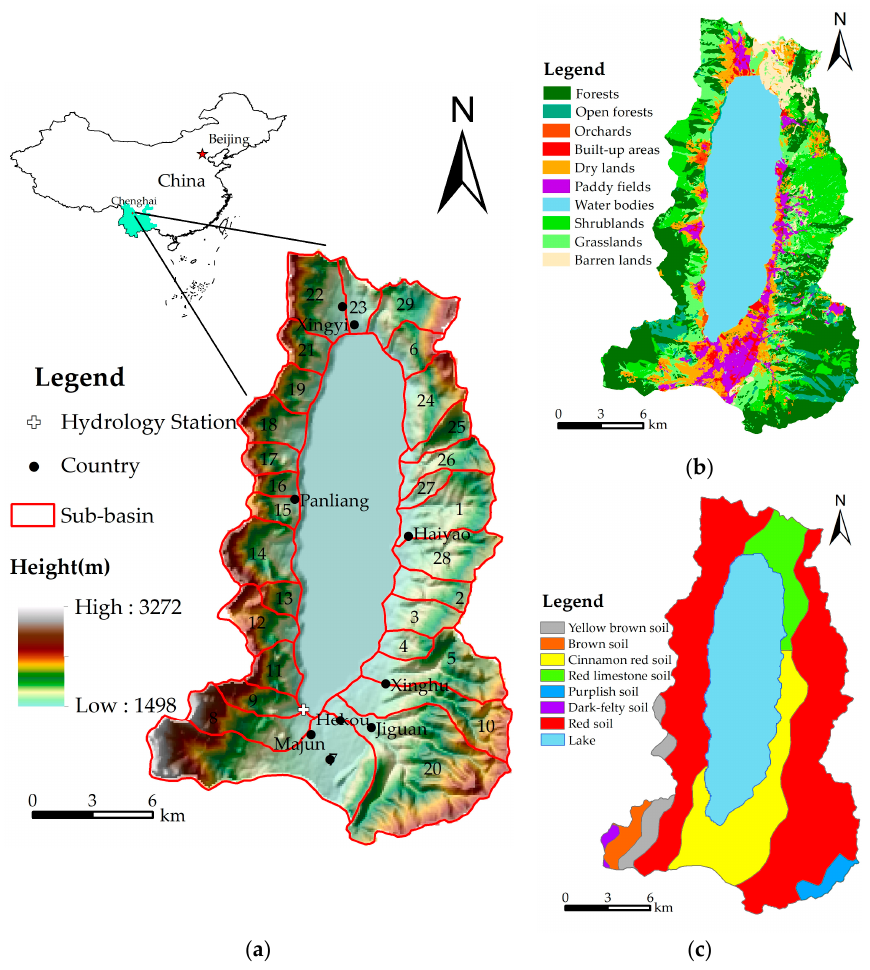
Figure 1. Location and topographic characteristics ( a ), land-use map ( b ) and soil map ( c ) of the Lake Chenghai watershed.